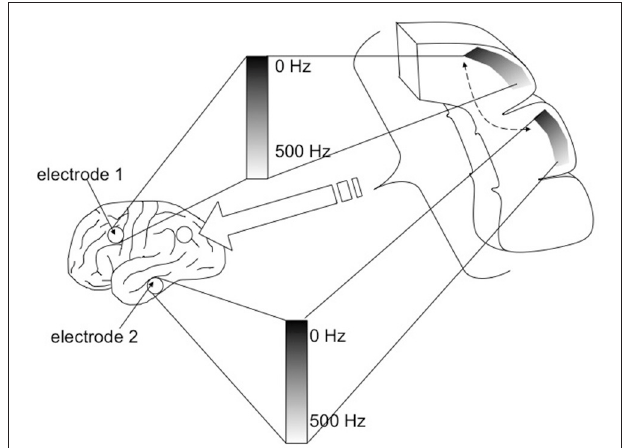
FIGURE 3 | Spectrotopy: an approach to mapping the brain’s own power spectral data on to itself. Just as primary auditory cortex deploys a tonotopic mapping where different sound frequencies are arranged topographically along the cortical surface, so too power spectral features of neural activity itself could be mapped along emulated cortex that in turn would send inputs back into the real brain. While the brain localizes sound in three-dimensional physical space, capturing local field potentials from multiple brain areas entails higher dimensionality. Fortunately emulated cortex is free from the spatial anatomical constraints of real cortex, and could extend in different dimensions such that location along the emulated cortex would move along gradients indexing both frequency and real brain cortical origin. Each emulated minicolumn could represent both frequency and temporal phase features of the recorded activity. Figure reprinted from Serruya and Kahana (2008) with permission from